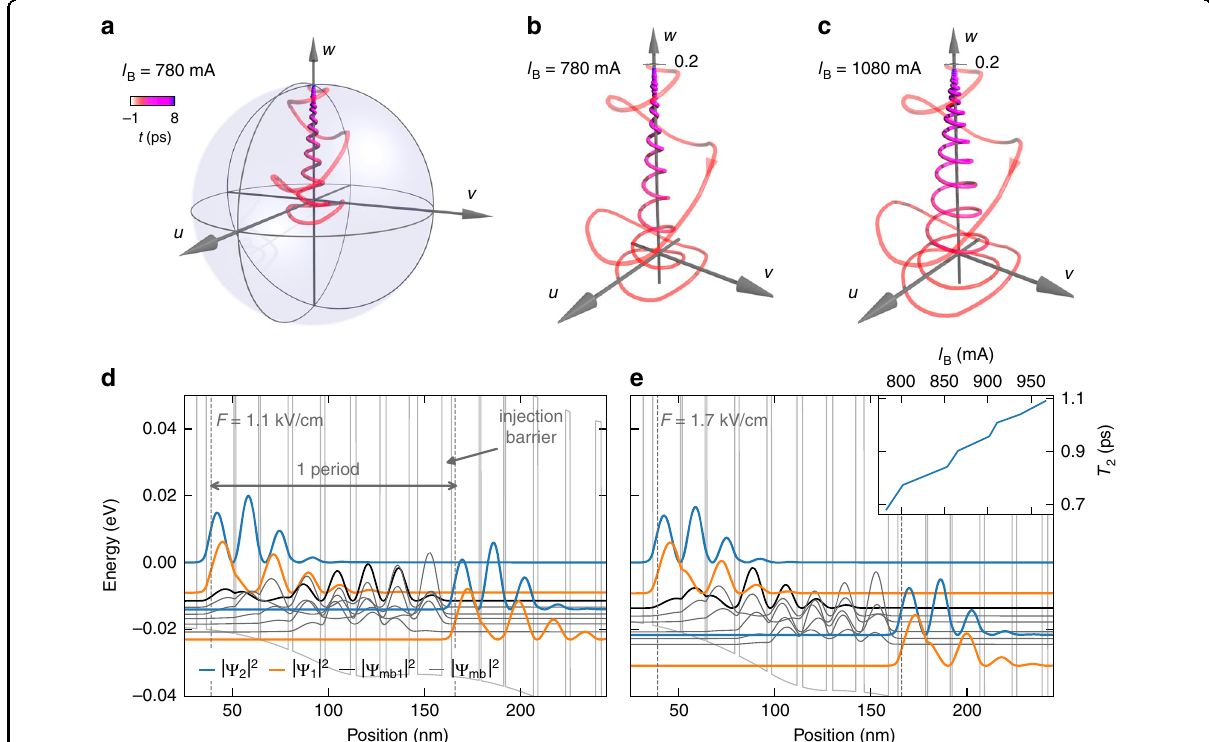
Fig. 4 Microscopic picture of the QCL dynamics. a Temporal evolution of the QCL ’ s density matrix, shown in a reduced Bloch sphere with a radius of 0.2 for a delay time of τ = 0 ps and a bias current of I B = 780 mA. b Close-up view of the trajectory of the Bloch vector shown in a . c As b , but for I B = 1080 mA. d Simulated band diagram of the QCL under an electric fi eld of F = 1.1 kV cm − 1 . The blue and orange lines represent the squared modulus of the wave function of the upper and lower laser level (| Ψ 2 | 2 and | Ψ 1 | 2 , respectively). Additionally, the highest miniband state | Ψ mb1 | 2 as well as the other miniband states | Ψ mb | 2 are shown in black and gray. e As in d but for a bias voltage of F = 1.7 kV cm − 1 . Inset: Calculated dependence of T 2 on the bias current I